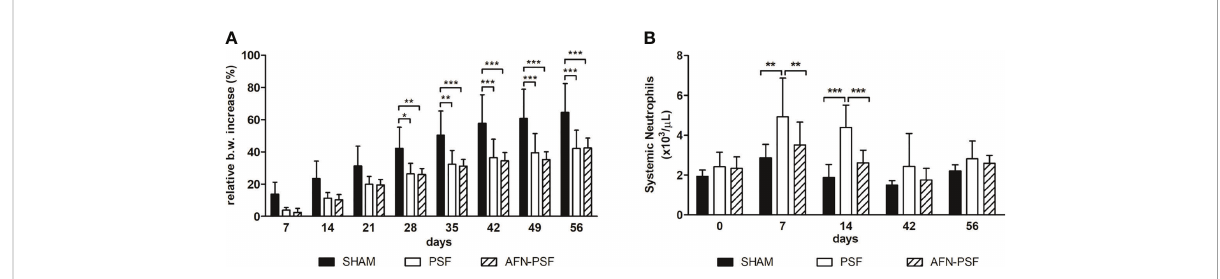
FIGURE 3 Clinical data. (A) The histogram depicts the relative body weight increase in the experimental groups over time. (B) The histogram depicts the systemic neutrophil count in the experimental groups over time. Comparisons between groups and time points were analyzed with two-way ANOVA and Bonferroni ’ s post hoc test. Statistical signi fi cance was p < 0.05 (*), < 0.01 (**), and < 0.001 (***); n = 5 SHAM, n = 8 PSF, n = 10